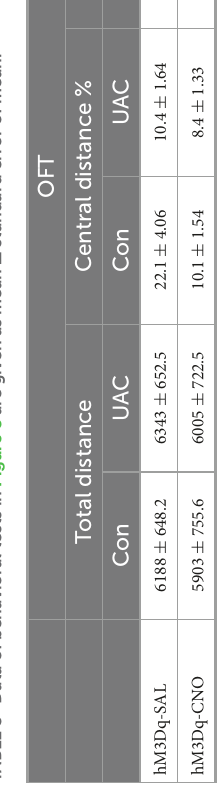
( Figure 2B and Supplementary Figures 1B–D ). To verify that Vpdm VGLUT1 neurons were effectively inhibited after clozapine-N-oxide (CNO) administration, triple-staining for c-FOS/mCherry/DAPI was conducted. As shown in Figure 2C , fewer c-FOS/mCherry/DAPI triple-labeled neurons were observed in hM4Di-CNO mice than in hM4Di-Saline (hM4Di- SAL) mice ( p = 0.0009, Figure 2C ). After 2 weeks of UAC, 3 mg/kg CNO was intraperitoneally injected into the mice, and behavioral assessments were performed 30 min later. The total distance traveled in the OFT ( Figure 2D and Table 2 ) did not differ significantly among the hM4Di-CNO, hM4Di-SAL and mCherry-CNO groups, demonstrating that the treatments did not impact the general locomotor abilities of the mice. Two-way ANOVA revealed UAC × hM4Di-CNO interaction effects [OFT: central distance, F ( 2 , 37 ) = 7.224, p = 0.0022; central time, F ( 2 , 37 ) = 5.228, p = 0.0100, Figure 2E and Table 2 ; EPM: open arm entries, F ( 2 , 37 ) = 3.319, p = 0.0472; open arm time, F ( 2 , 37 ) = 3.660, p = 0.0355, Figure 2F and Table 2 ]. In the UAC groups, post hoc analyses revealed that inhibition of VGLUT1-ir neurons in the Vpdm (hM4Di-CNO group) increased the percentage of central distance traveled ( vs. mCherry-CNO, p = 0.0011; vs. hM4Di-SAL, p = 0.0012, Figure 2E ) and the time spent in the central area ( vs. mCherry-CNO, p = 0.0302; vs. hM4Di-SAL, p = 0.0493, Figure 2E ) in the OFT. Similarly, in the EPM test, the percentage of open arm entries ( vs. mCherry- CNO, p = 0.0120; vs. hM4Di-SAL, p = 0.0170, Figure 2F ) and the time spent in the open arms ( vs. mCherry-CNO, p = 0.0055; vs. hM4Di-SAL, p = 0.0071, Figure 2F ) were significantly increased after Vpdm VGLUT1 inhibition. These results suggest that the inhibition of VGLUT1-ir neurons in the Vpdm produces anxiolytic effects. Moreover, anxiety-like behaviors were not alleviated in the hM4Di-SAL and mCherry-CNO groups, which indicates that chemogenetic operations and CNO injections have no effect on the anxiety-like behaviors induced by UAC.